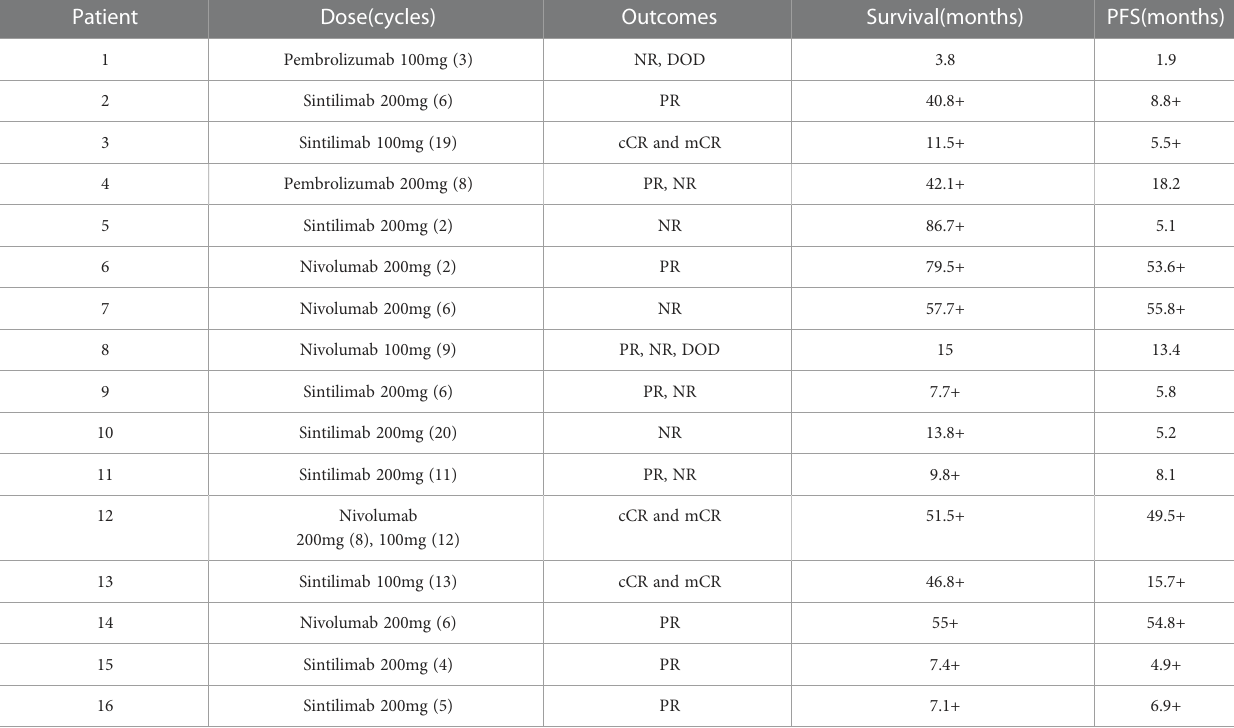
TABLE 2 Treatments and outcomes of PD-1 inhibitor infusions. Patient